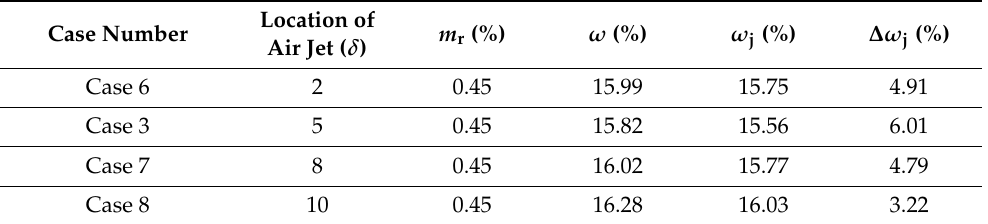
Table 3. Related parameters of various locations of air